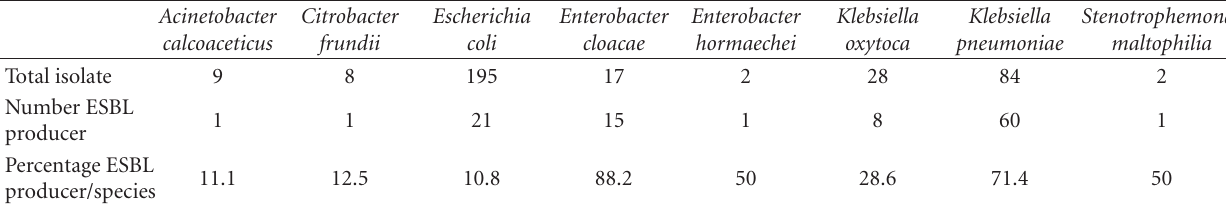
Table 2: ESBL production among the gram-negative